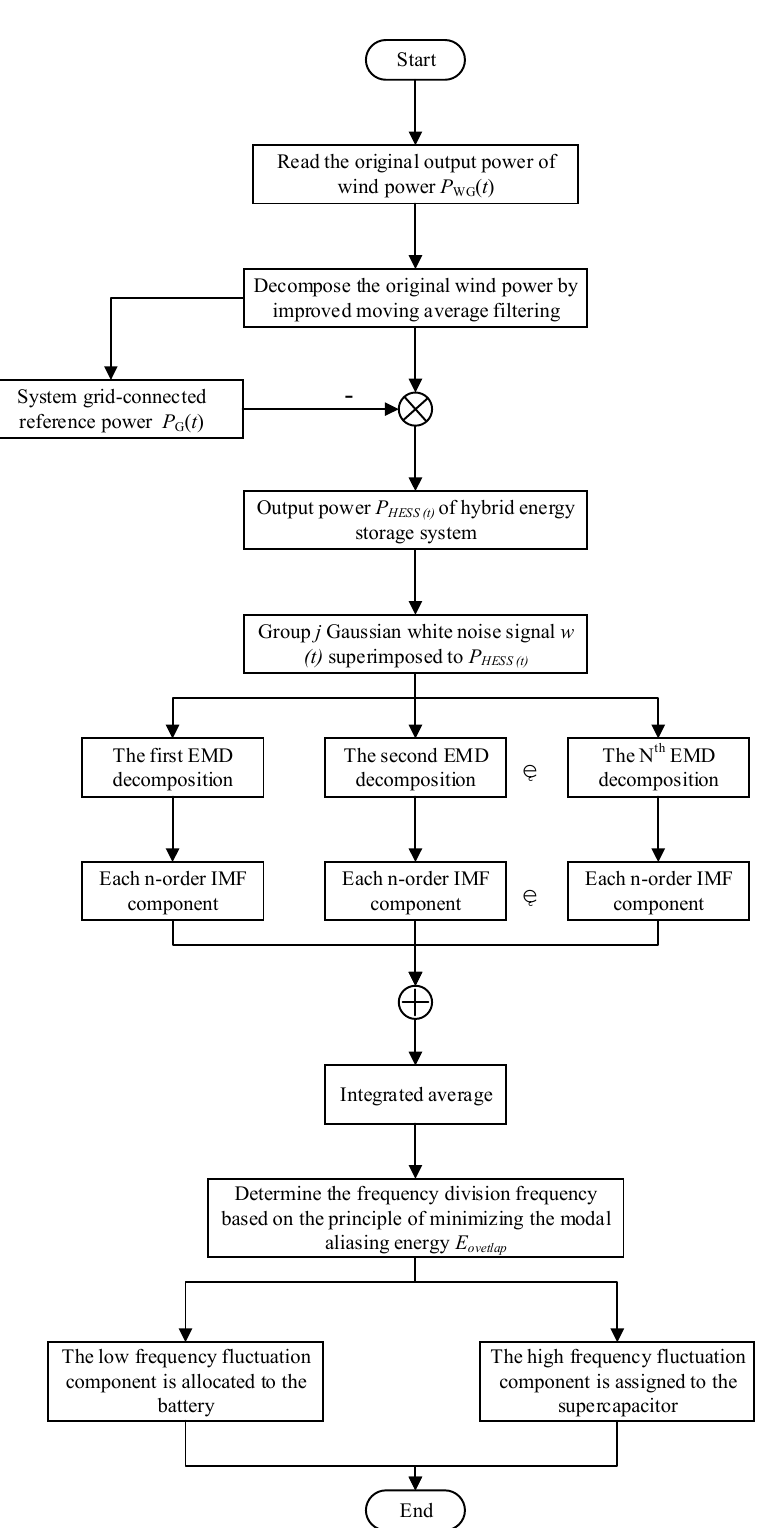
Figure A1. Improved power allocation strategy based on moving average filtering and EEMD de ‐ composition.